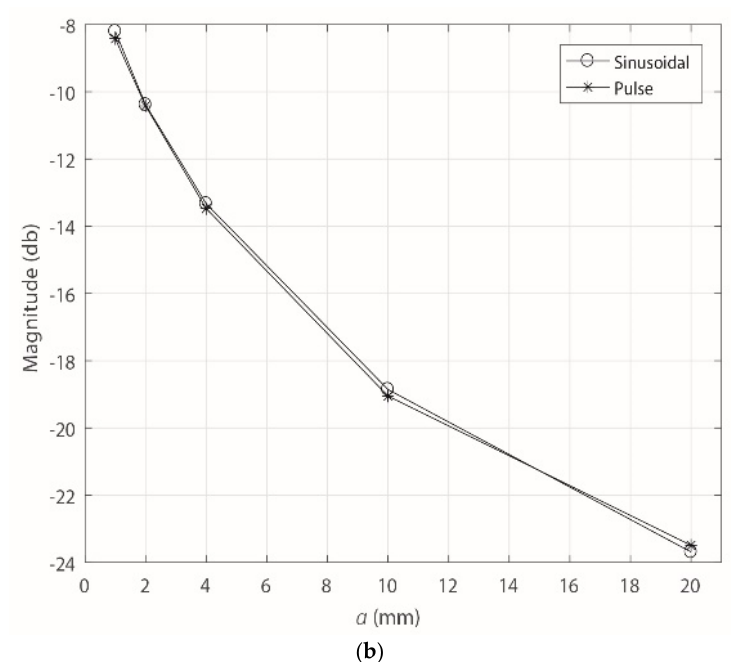
Figure 14. Comparison of the results obtained for 1.85 MHz. ( a ) Frequency response of the sensor; ( b ) sensor gain with a variation of the separation from the line through which the pulses flow.